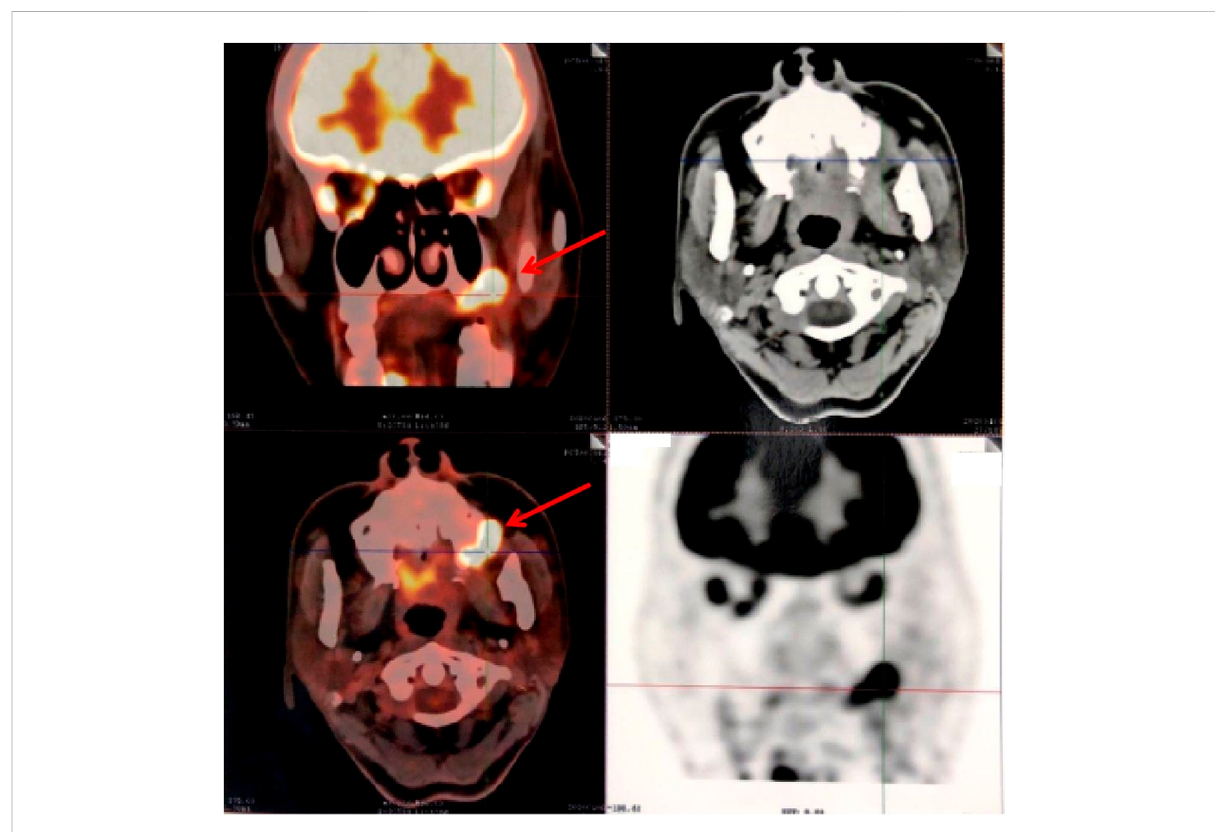
FIGURE 1 PET-CT axial view shows metabolic hyperactivity of the maxillary mass on the left lateral